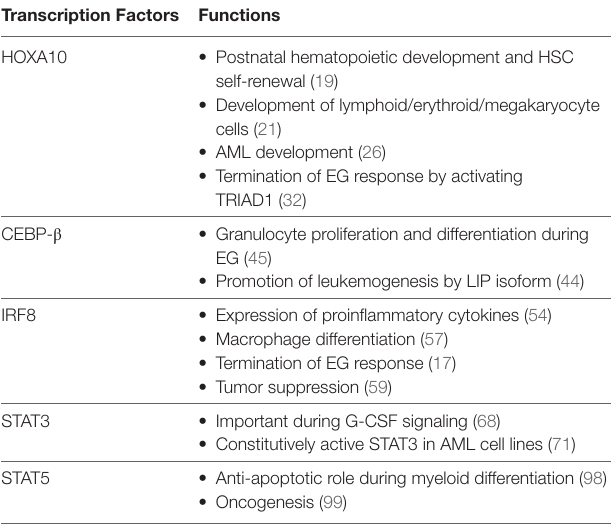
TAbLe 1 | Transcription factors with intersecting roles in EG and